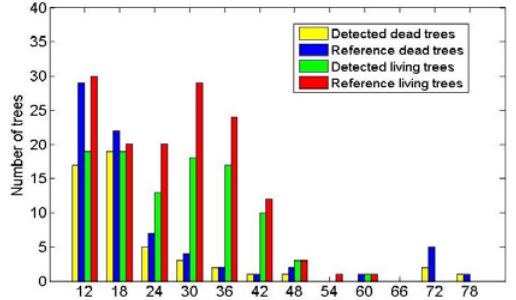
Figure 7. Distribution histogram of detected and reference trees according to the DBH – leaf-on dataset